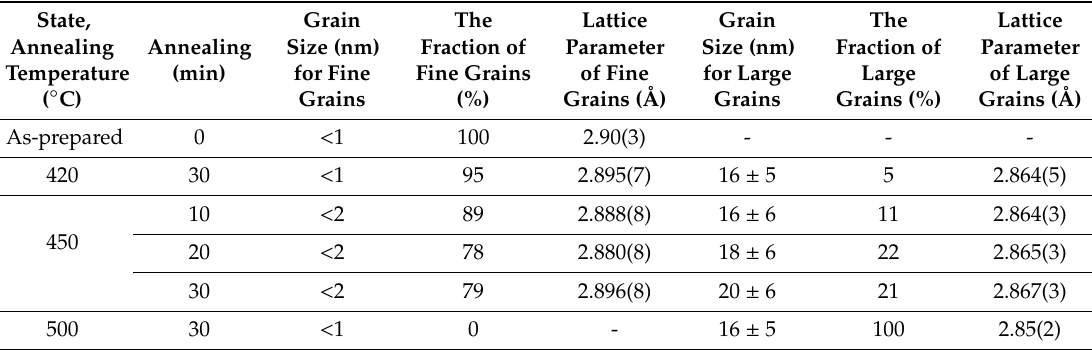
Table 1. Structural parameters of the 200 nm films of the Fe 73.5 Nb 3 Cu 1 Si 13.5 B 9 alloy obtained after di ff erent heat treatment